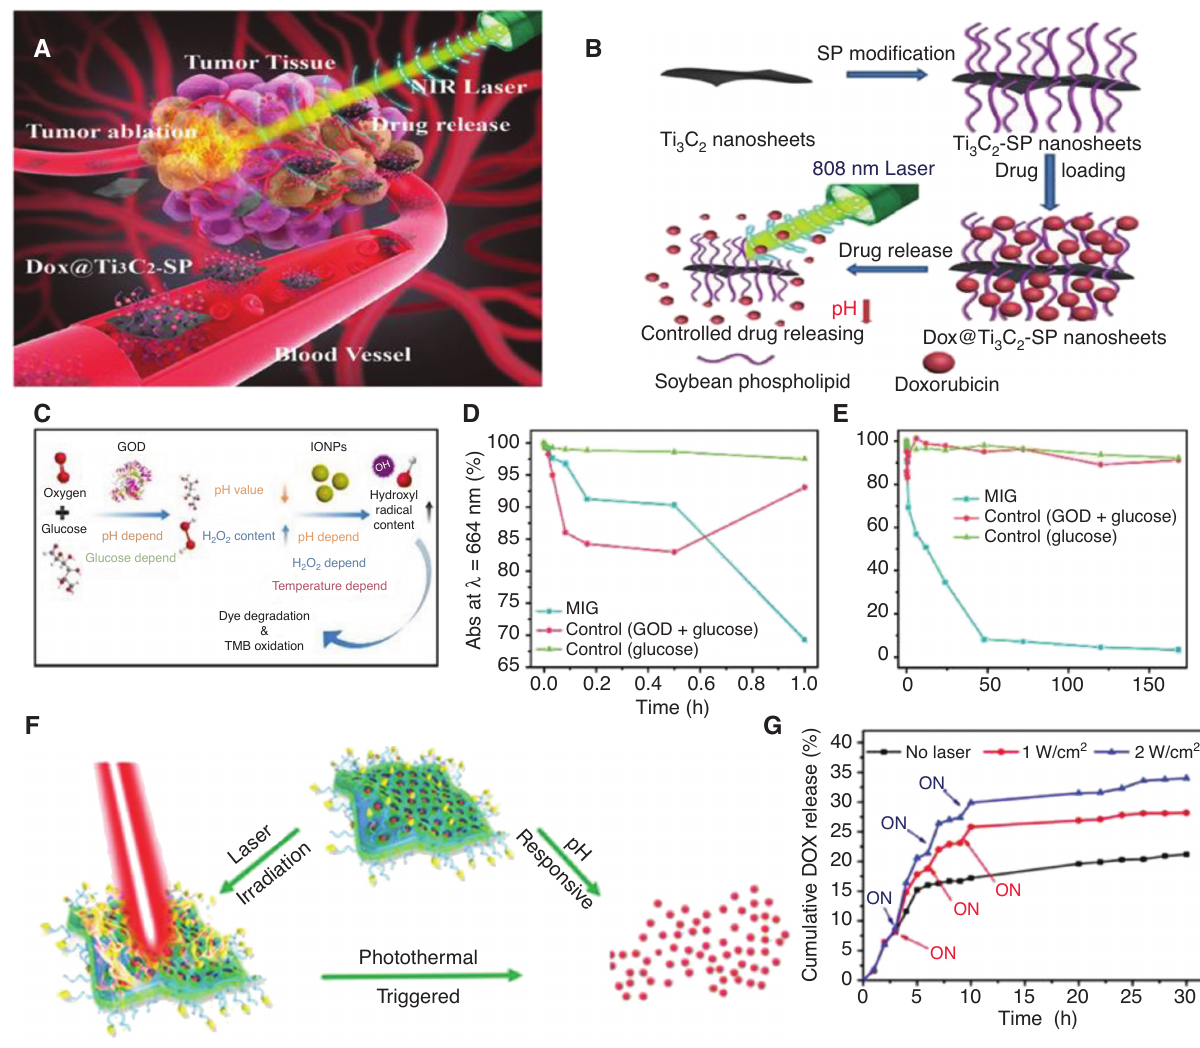
Figure 7: Chemotherapy and PTT of cancer. (A) Schematic of a Ti C -based drug delivery system for in vivo synergistic photothermal and chemotherapy for cancer, including 3 2 intravascular transport, accumulation into tumors, controlled drug release, and NIR-triggered photothermal ablation of tumor tissue [104]. (B) Schematic for surface modification of Ti C nanosheets by SP, further surface drug loading, and stimulant-responsive drugs released by 3 2 internal or external irradiation [104]. (C) Schematic illustration of the detailed mechanism of sequential catalytic processes based on IONP as a Fenton reaction nanocatalyst and an MIG nanoplatform for natural GOD [105]. (D and E) Fading curves of experimental group, control group 1, and control group 2 using methylene blue as chromogenic agent within (D) 1 h and (E) 7 days [105]. (F) Schematic illustration of pH/photothermal-triggered drug release from DOX-loaded Ti C @mMSNs-RGD [105]. (G) Cumulative DOX release from DOX-loaded Ti 3 2 mMSNs-RGD in phosphate-buffered saline (pH 7.4) as triggered by 808 nm NIR lasers at elevated power density